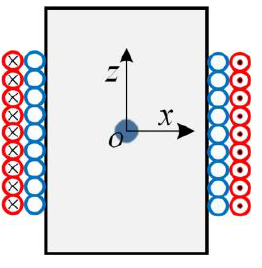
Figure 3. Simplified model of the coil. Table 1. Numerical simulation modeling parameters.